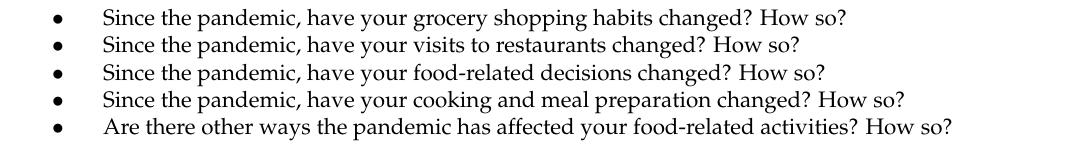
Table 1. COVID-19 Interview